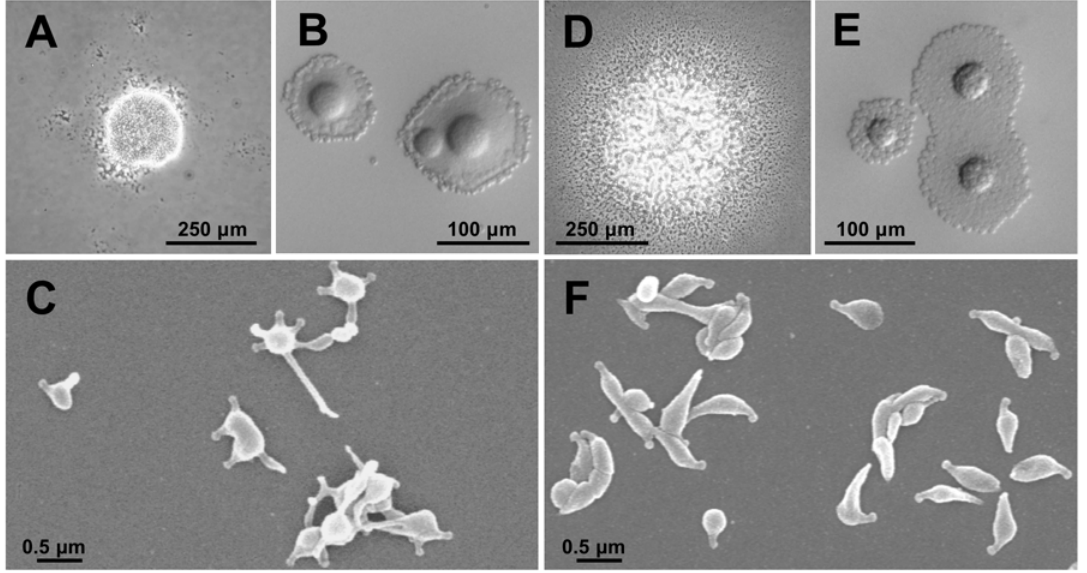
Figure 7. Phenotype of the cI-6 and c30 mutants. (A) Colony morphology, (B) qualitative hemadsorption activity and (C) scanning electron microscopy analysis of the cI-6 mutant. (D) Colony morphology, (E) qualitative hemadsorption activity and (F) scanning electron microscopy analysis of the C30 mutant. doi:10.1371/journal.pone.0007452.g007 PLoS ONE |